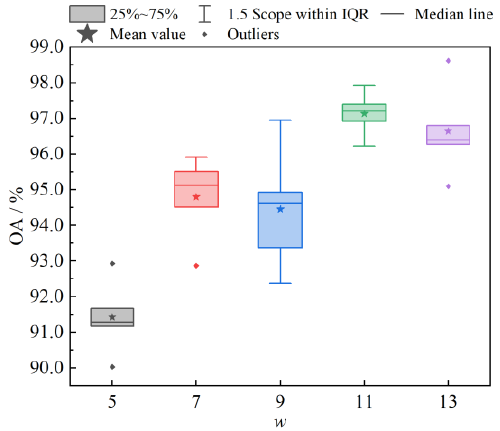
Figure 7. Box plots of OA with different sliding windows w .